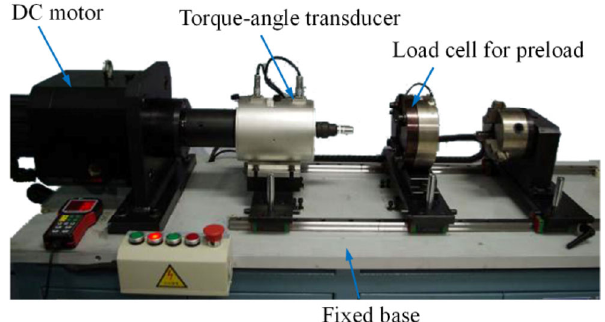
Fig. 20 Torque–tension test machine. Reproduced with permission from Ref. [22], © Elsevier Ltd. 2020.